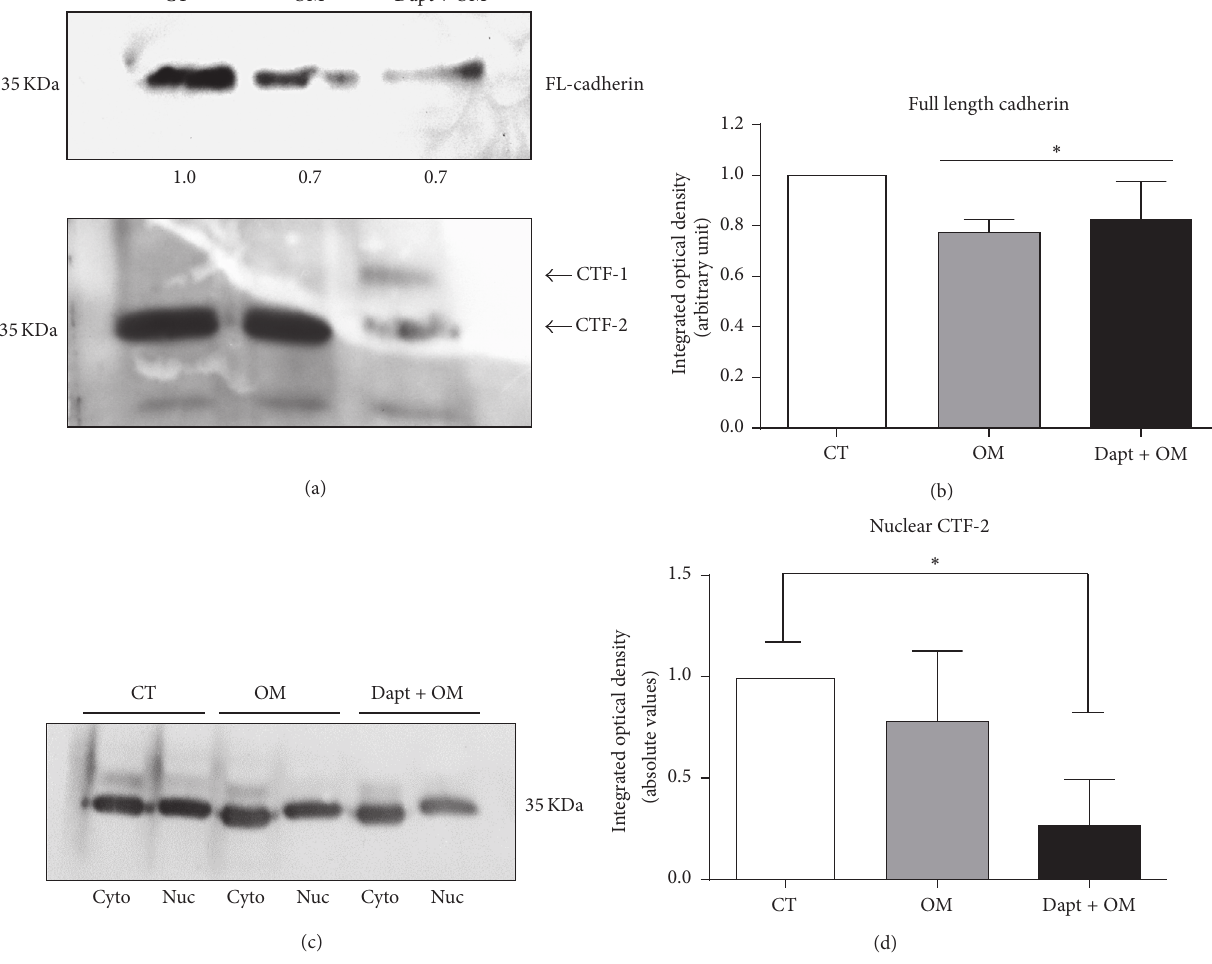
Figure 4: PS1/ 𝛾 -secretase-mediated cadherin cleavage occurs during osteogenic differentiation of BMSCs, generating a C-terminal intracellular fragment (CTF-2) that translocates to nucleus. BMSCs were osteoinduced for 48 h in the presence of Dapt. (a) Representative immunoblotting showing a full-length cadherin band (135kDa) and its cleavage products (CTF-1 and CTF-2) in total protein extracts. (b) Densitometric quantification of the 135kDa cadherin band. Bars show mean ± SD of 4 independent experiments. (c) Representative immunoblotting showing CTF-2 fragments (35kDa) in cytoplasmic and nuclear fractions. (d) Quantification of nuclear CTF-2 in 3 experiments. CT = control undifferentiated cells; OM = osteogenic medium; Dapt + OM = osteogenic medium with Dapt. ∗ 𝑝 < 0.05 relative to